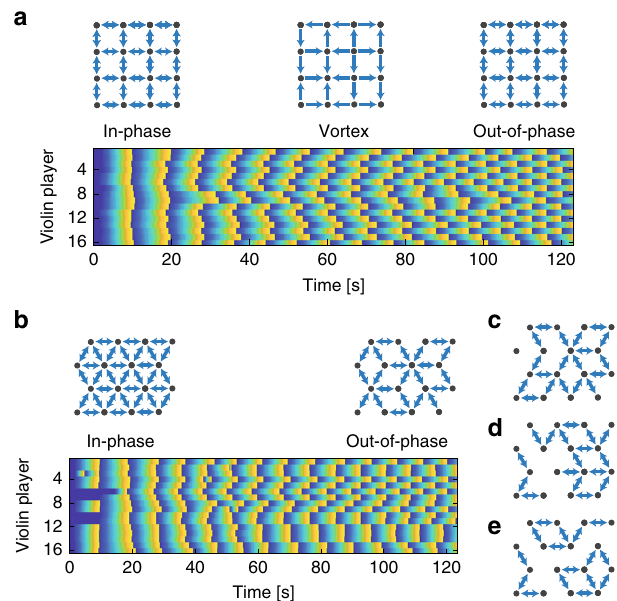
Fig. 7 Sixteen violin players arranged in square and triangular con fi gurations. a The evolution of the square lattice con fi guration as a function of time showing in-phase, vortex, and out-of-phase states of synchronization. b The evolution of the triangular con fi guration showing that for the out-of-phase synchronization state, the connectivity of the network is reduced in order to reach a stable solution. We repeat the experiment and obtain a different solution each time, based on the same motifs. Three representative solutions are shown in c – e